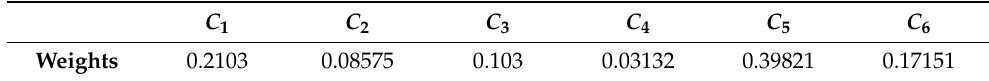
Table 12. Criteria weights using BWM.